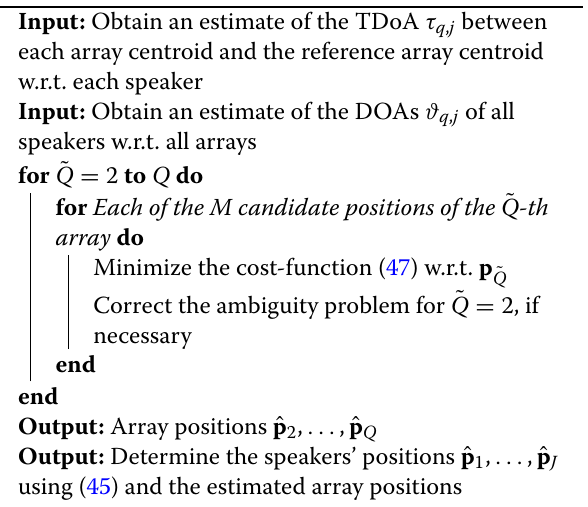
Algorithm 3: Naïve geometrical technique for joint speakers’ and arrays’ positions estimation.